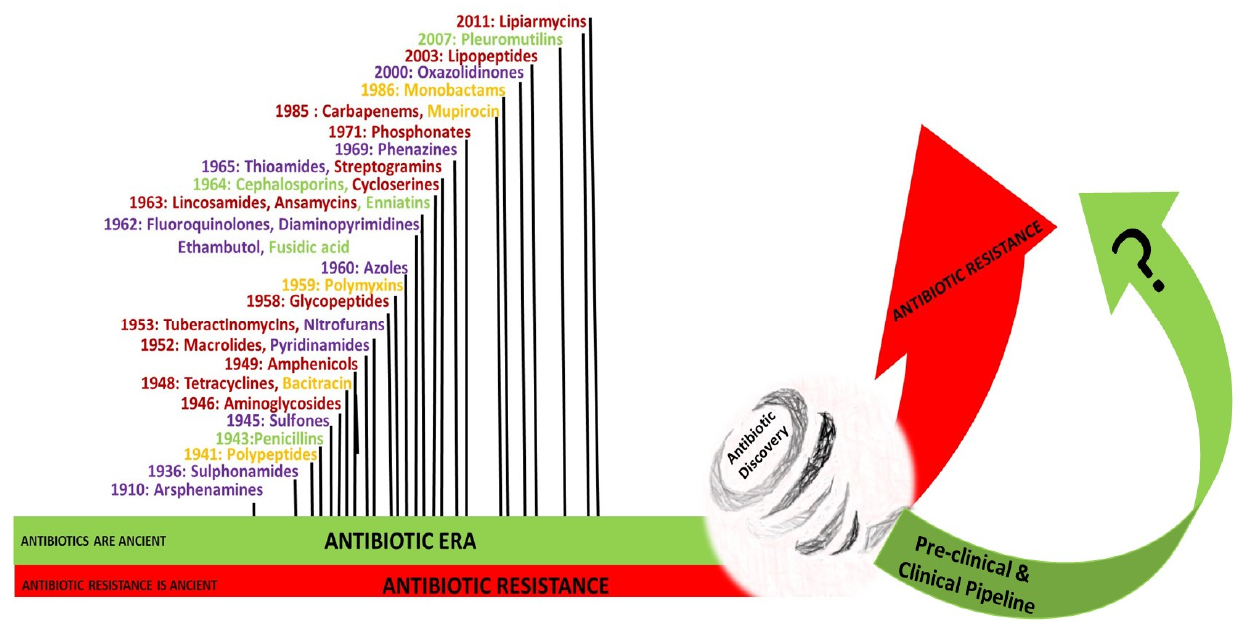
Figure 3. The chase and the race between antibiotics and antimicrobial resistance. The classes of antibiotics and dates of clinical introduction into the market are shown. Purple color: Synthetic antibiotics; gold color: antibiotics from other bacteria; green color: antibiotics from fungi; red color: antibiotics from actinomycetes [154].